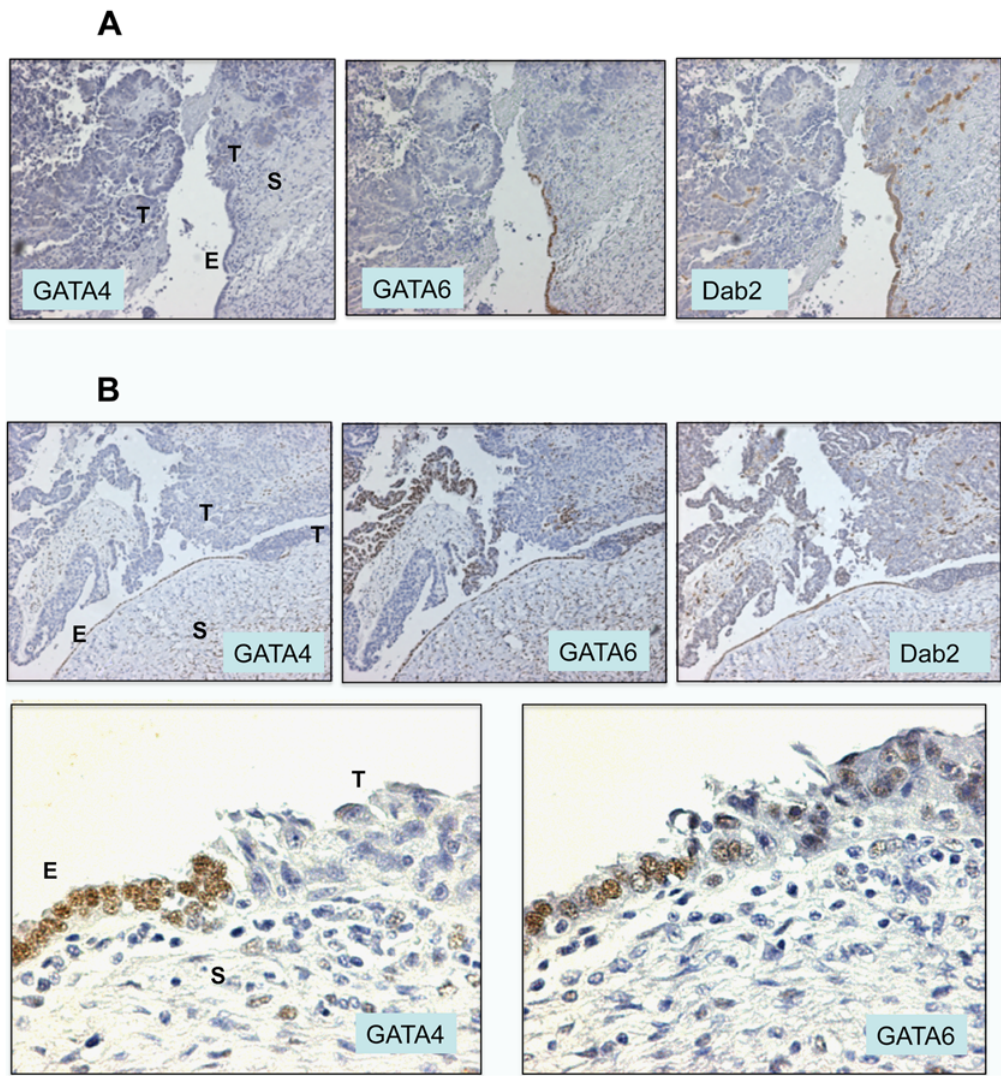
Figure 3. Loss of GATA4 and/or GATA6 closely correlates with epithelial morphological transformation. Examples of human ovarian cancer stained for GATA4, GATA6, and Dab2 in adjacent tumor sections. A . An ovarian surface epithelium that consists of a morphological normal surface epithelium (arrow head) contiguously linking malignant cells (arrow) that have either invaded into stroma or expanded into areas around the ovary. GATA4 is negative in both morphological normal or neoplastic epithelial cells. The epithelial cells in the morphological normal epithelium are positive for GATA6 and Dab2, and the malignant cells are negative for GATA6 and Dab2. Some scattered cells in the stroma are Dab2 positive but negative for GATA6. These cells are macrophages in which Dab2 expression is not GATA6-dependent. B . In this ovarian carcinoma, the epithelial cells in the morphological normal epithelium are positive for GATA4, GATA6, and Dab2, and the adjacent malignant cells are negative for GATA4, GATA6, and Dab2. The images were taken under a microscope with a 100 6 magnification. The stainings for GATA4 and GATA6 in the transition in panel B are shown in a higher magnification (400 6 ) at the lower panels. E , epithelium; C , cyst; S , stroma; T , tumor.